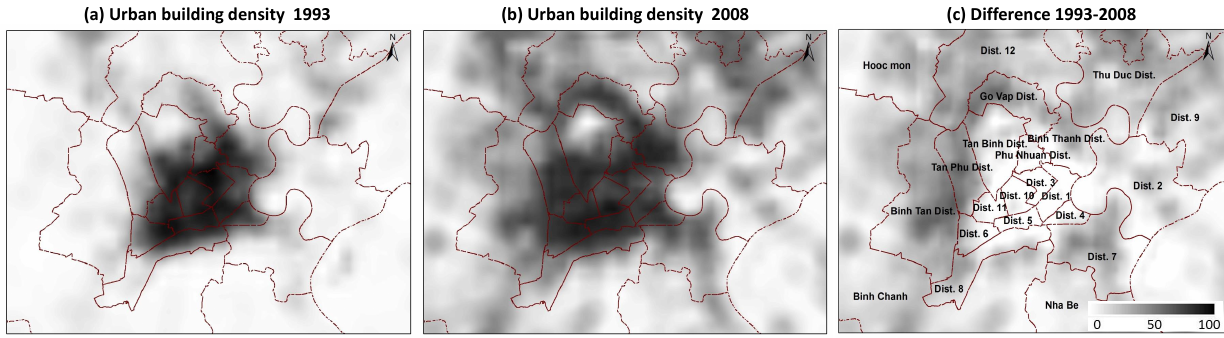
Figure 3. ( a ) Urban building density in 1993; ( b ) urban building density in 2008; ( c ) the difference between 1993 and